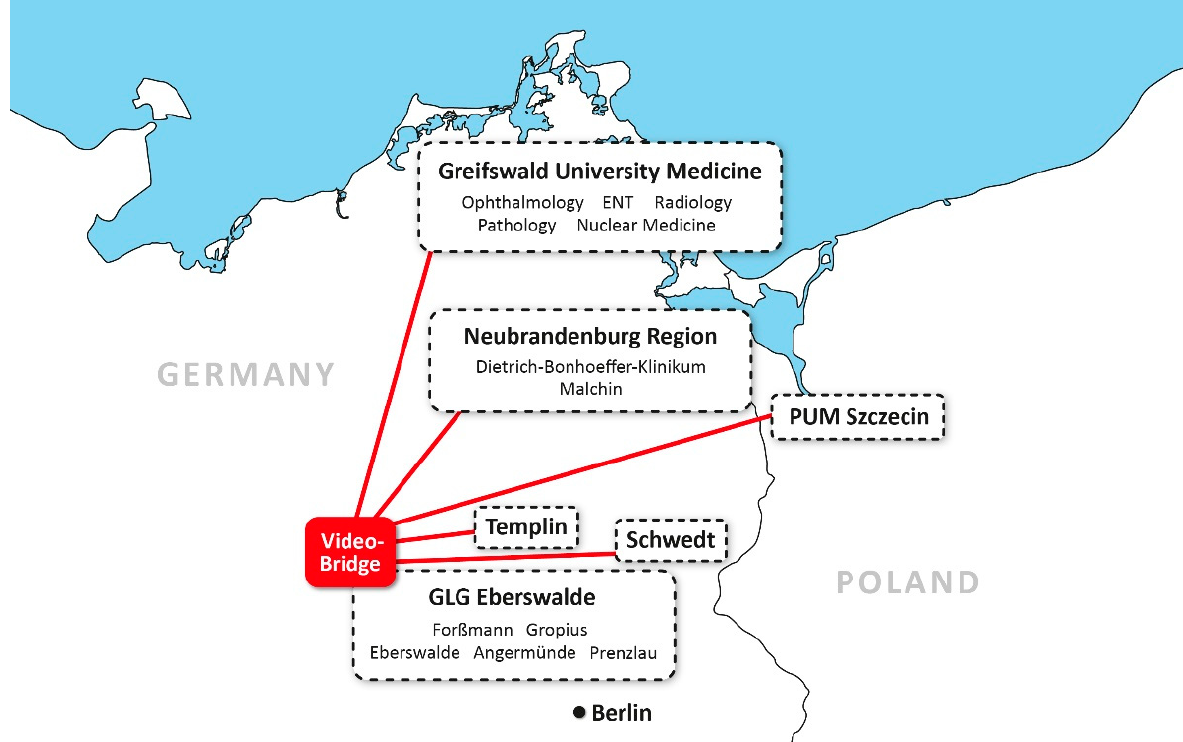
Figure 4. A videoconferencing network was the backbone of the telemedicine project. On the German side, there was a northern (Greifswald), a central (Neubrandenburg) and a southern rail (Eberswalde) with videoconferencing links; in Poland, only Szczecin took part. A “bridge”, actually a switch allowing multi-point videoconferencing to be initiated, was located in the south rail. This limited use of the network required three bridges to be installed. The system also allowed for the simultaneous viewing of medical images (x-ray, real-time endoscopy and pathology slides) and various documents on additional monitors. Please note that not all hospitals that participated in the program also participated in the videoconferencing network, explaining the difference in numbers.